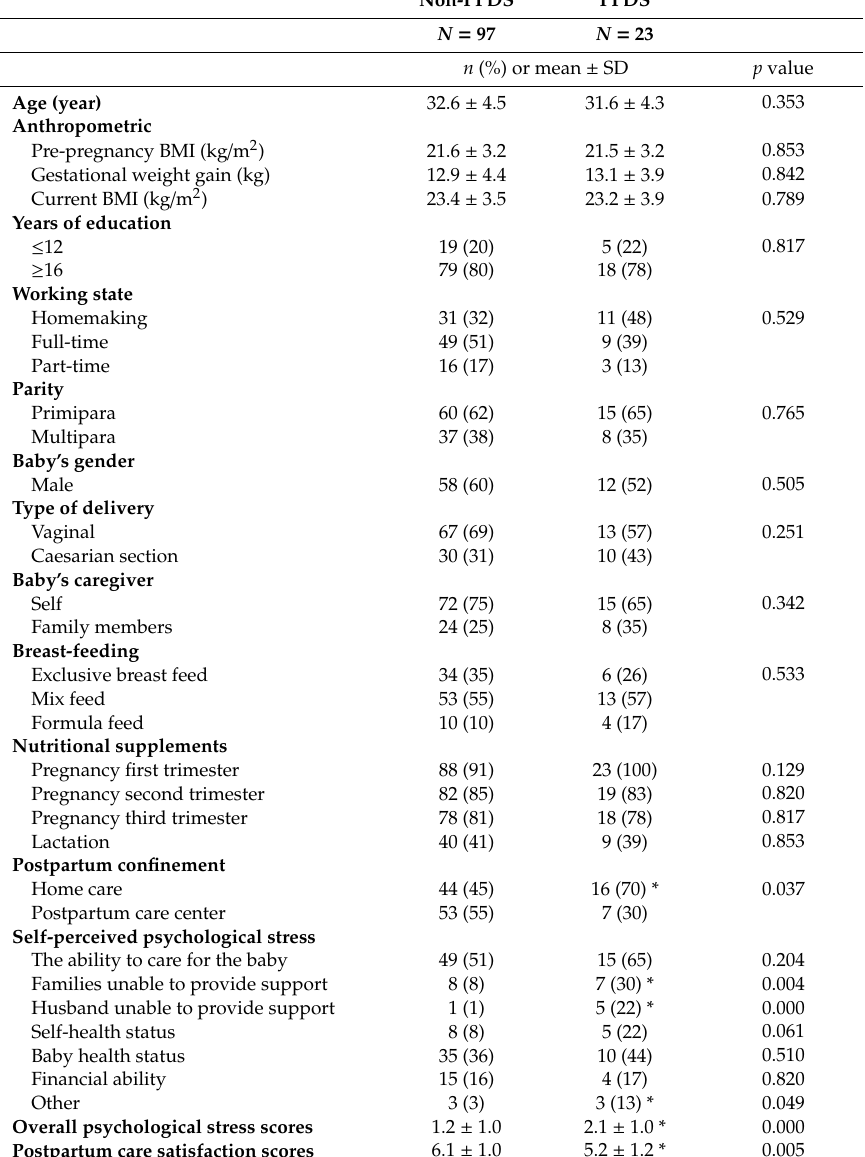
Table 1. Characteristics of the